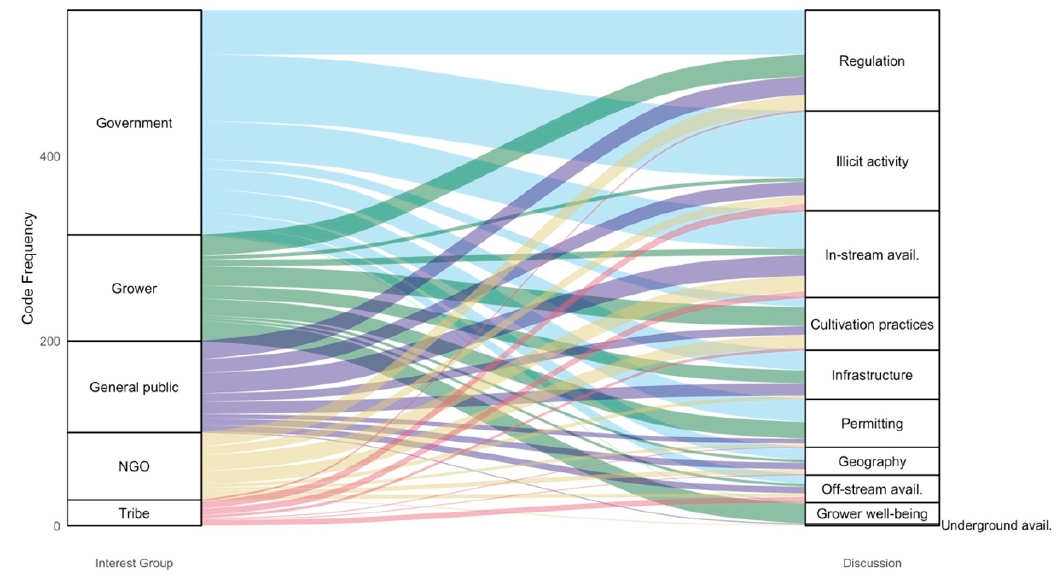
Figure 7. Frequency of code co-occurrence between a given Interest Group and Discussion theme.